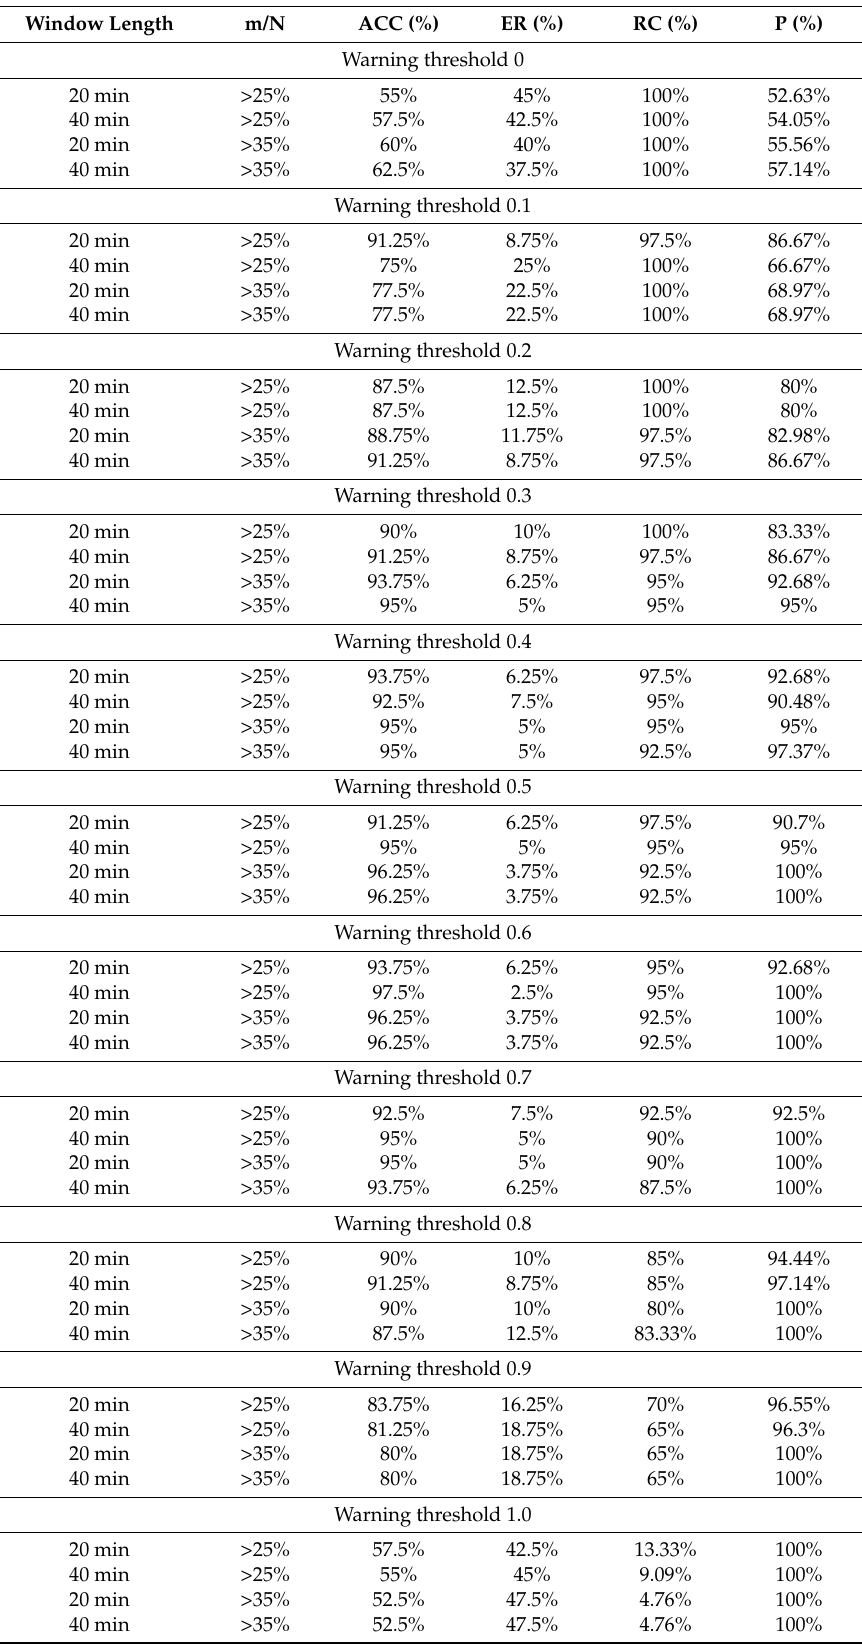
Table 2. Results of confusion matrix